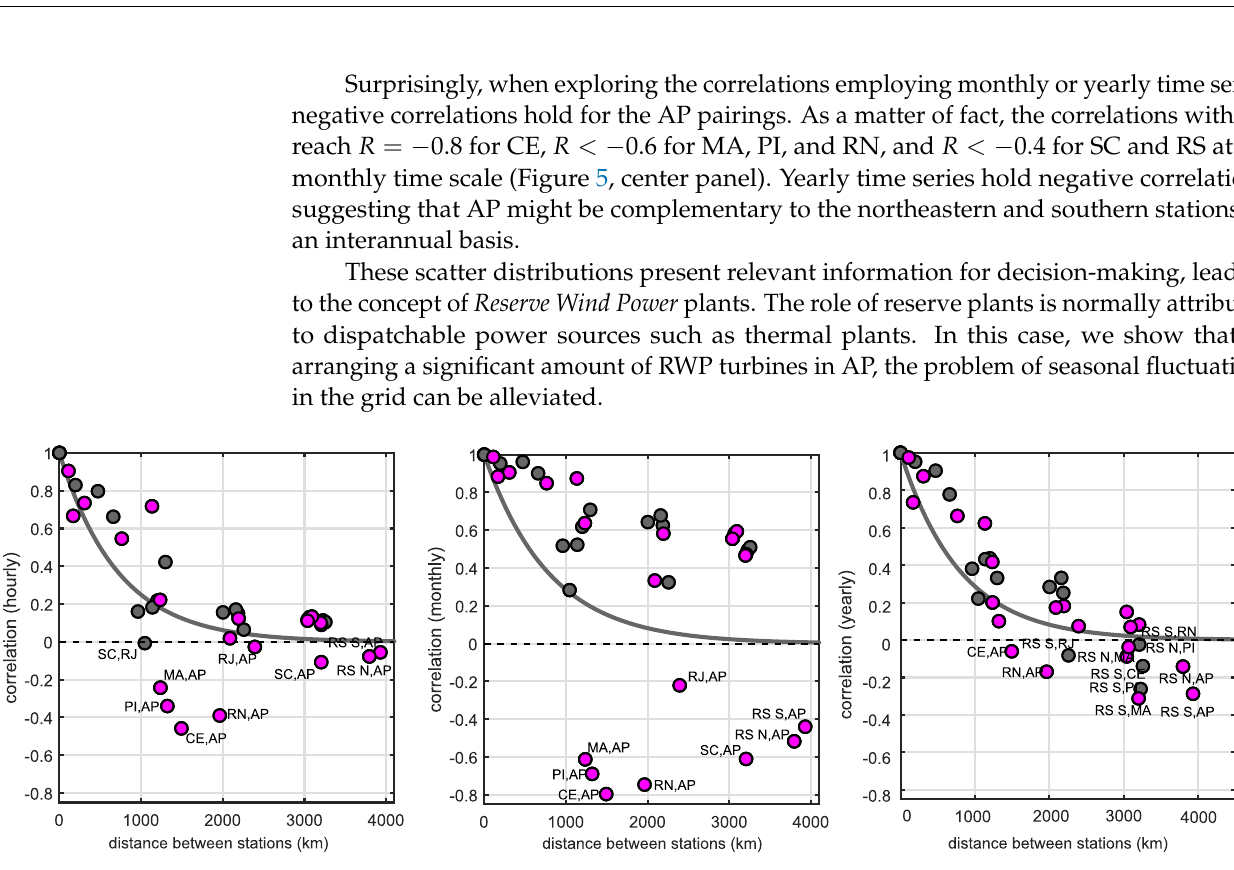
SC) suggested in this work. A gray curve represents these points’ exponential fit, R = exp( −